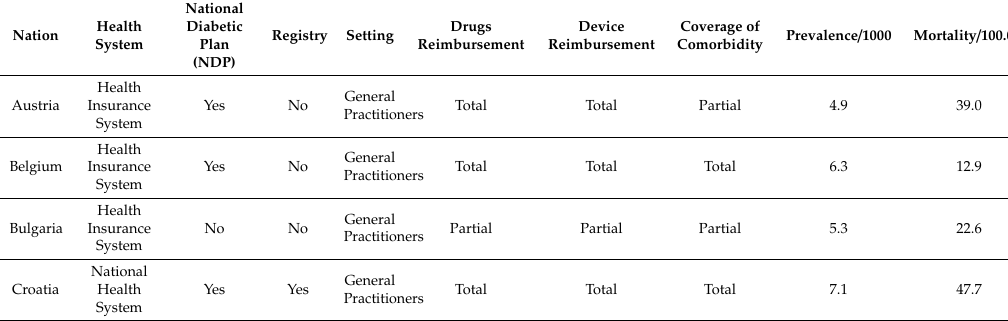
Table 3. Description and organization of health systems and occurrence measures.